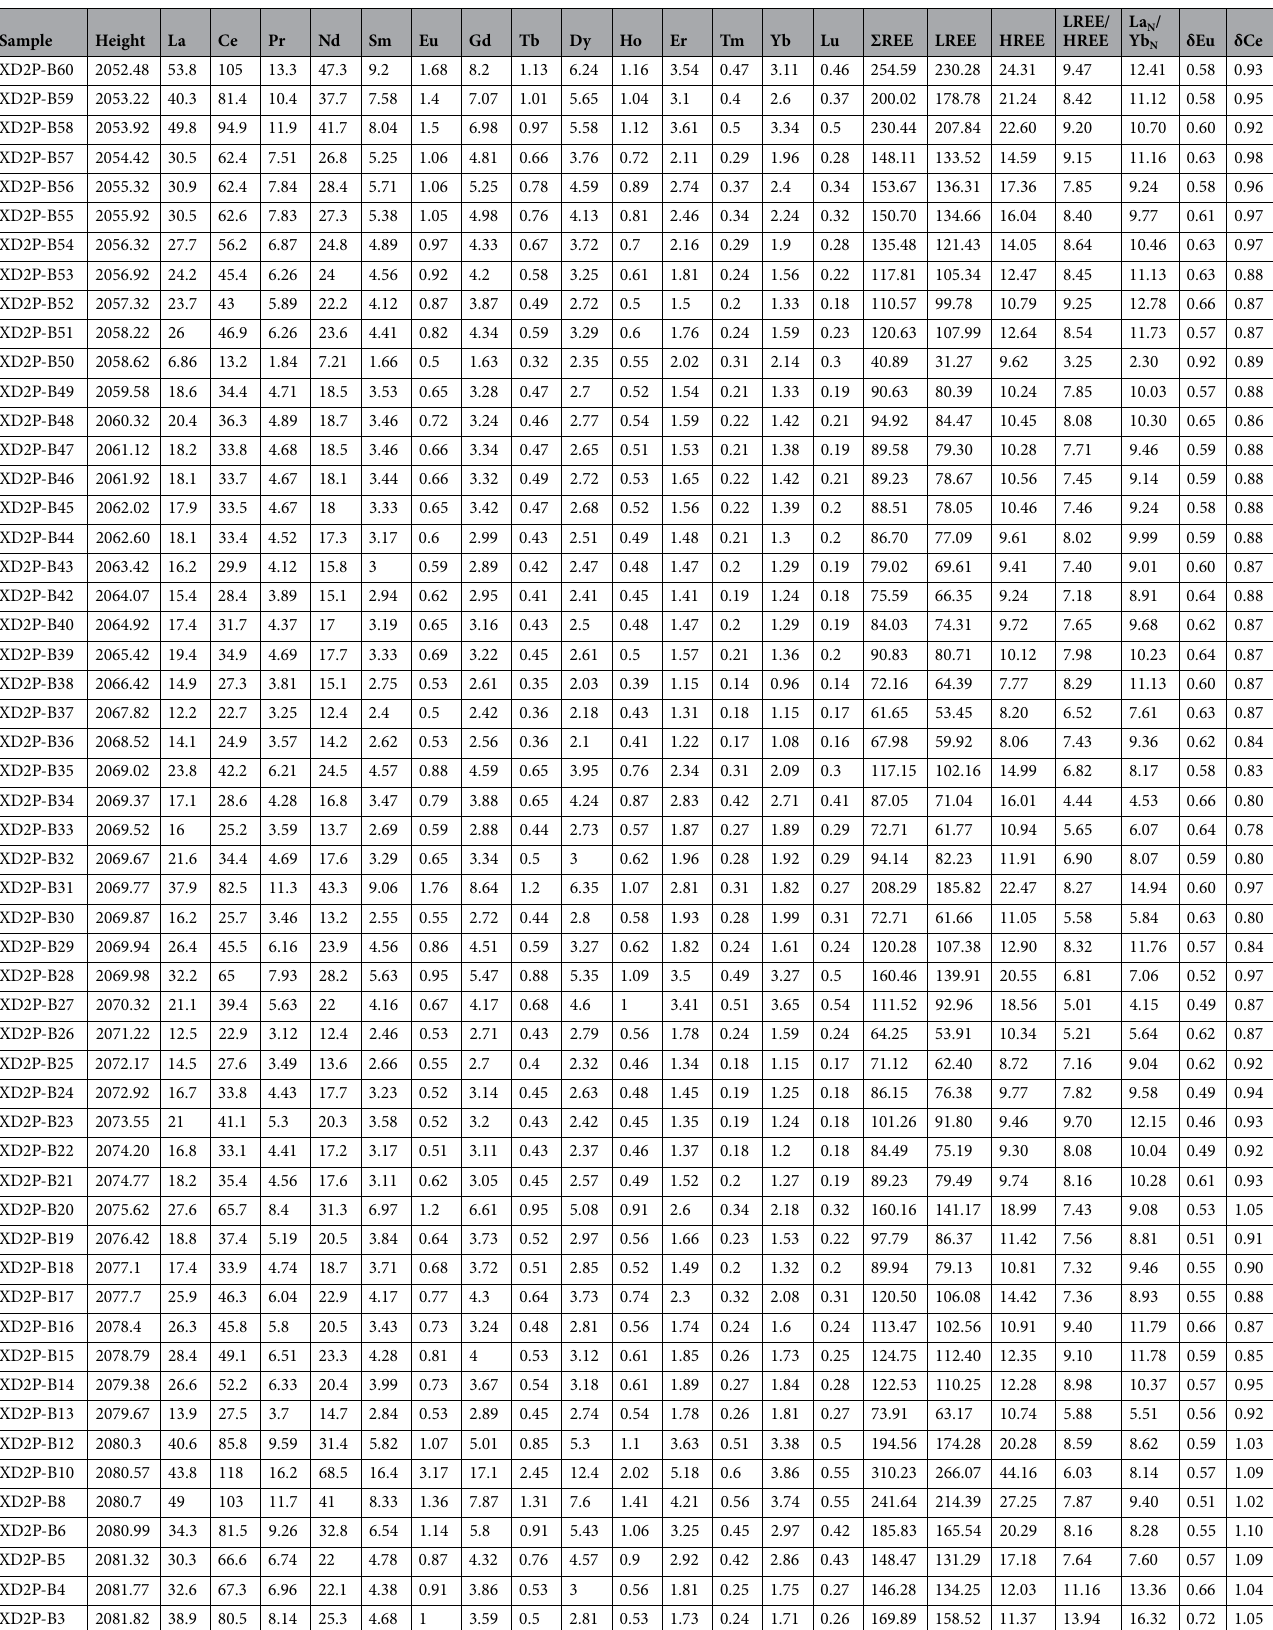
Table 3. Analytical data of rare earth elements (REEs) of the shales and carbonaceous marls from the Wufeng- Longmaxi formations in the Xindi No. 2